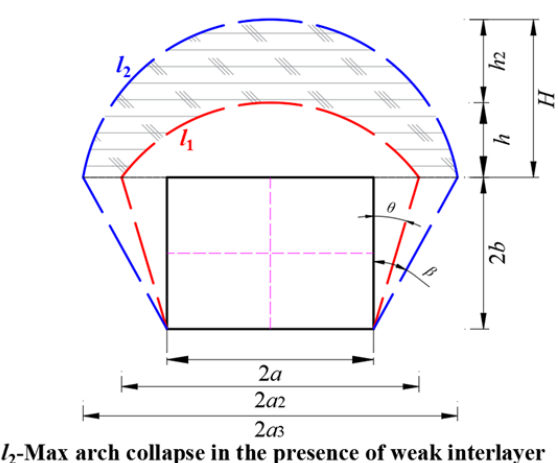
Figure 13. Calculation of the Maximum Arch Fall of the Horizontal Layered Roof with the Soft Interlayer.